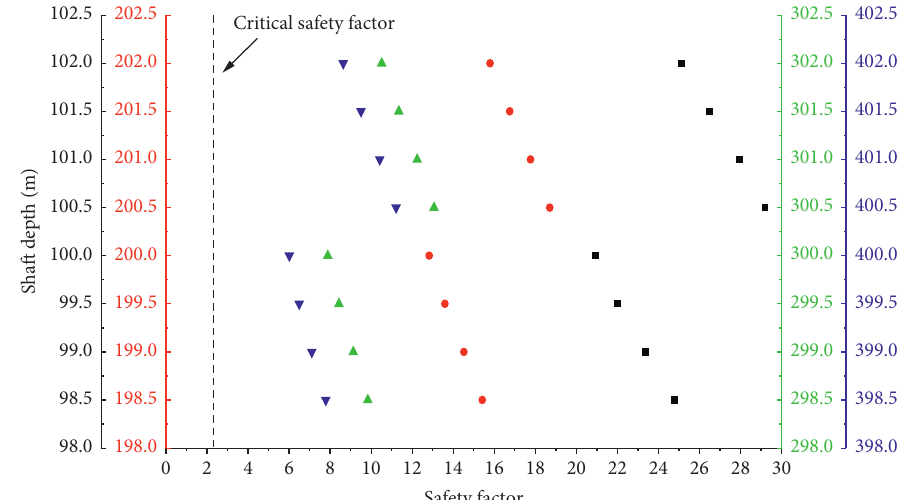
Figure 20: The safety factors of